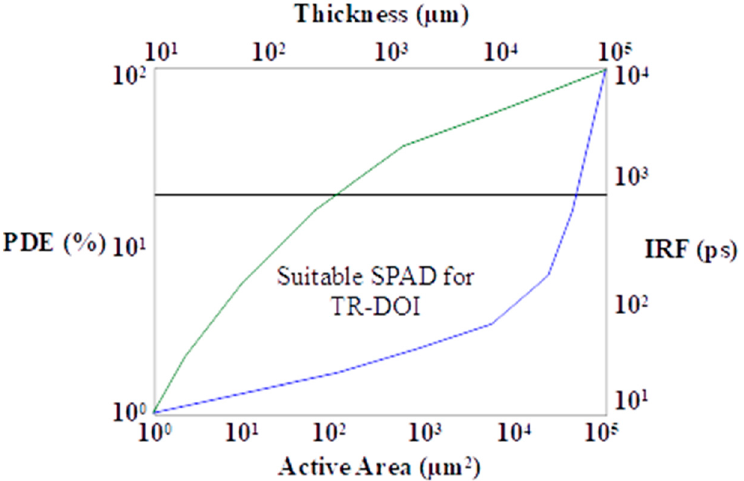
Figure 7. Compromise of SPAD: blue and green curves represent the IRF and the PDE changes with increasing thickness and the active area respectively, whereas the black line indicates maximum acceptable IRF SPAD .